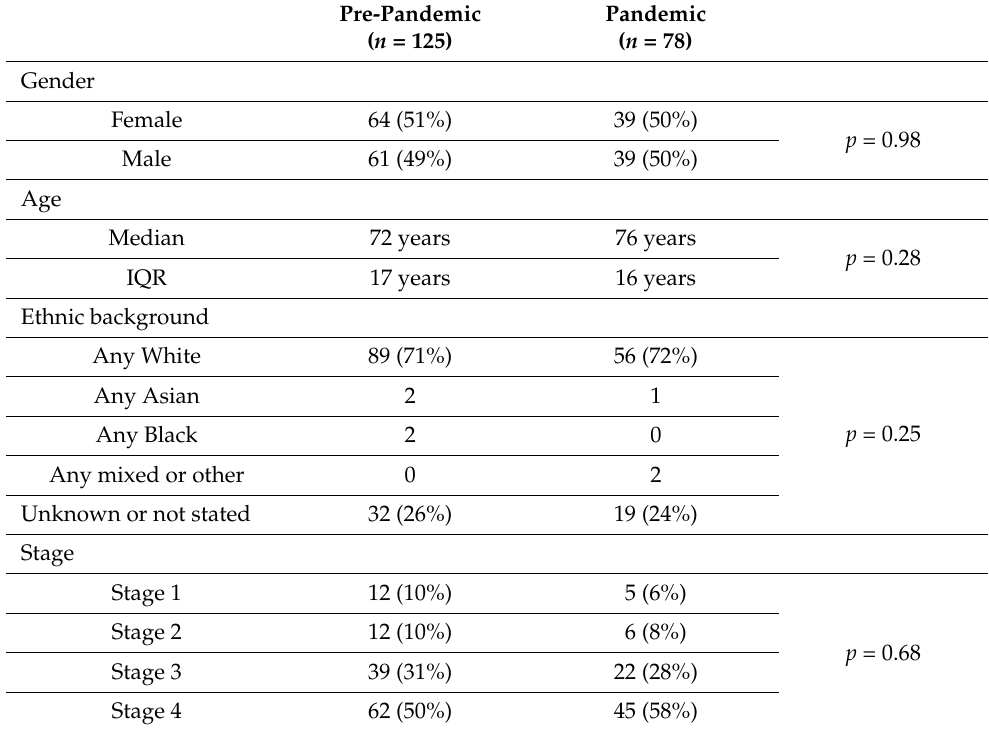
Table 1. Characteristics of patients diagnosed with